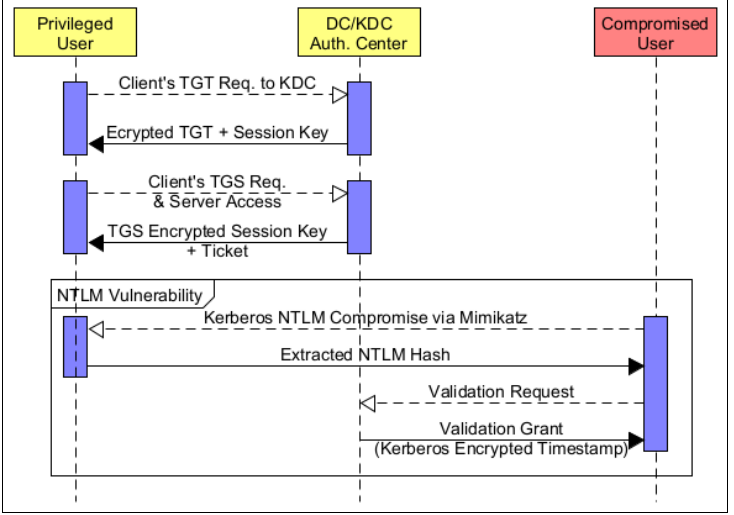
Figure 2. High-level view of Kerberos Authentication procedure, along with the NTLM hash extrac- tion vulnerability, that makes KDC prone to the Hashing Exploitation Attacks of Section 6.2, namely, PtH, PtT, Golden/Silver